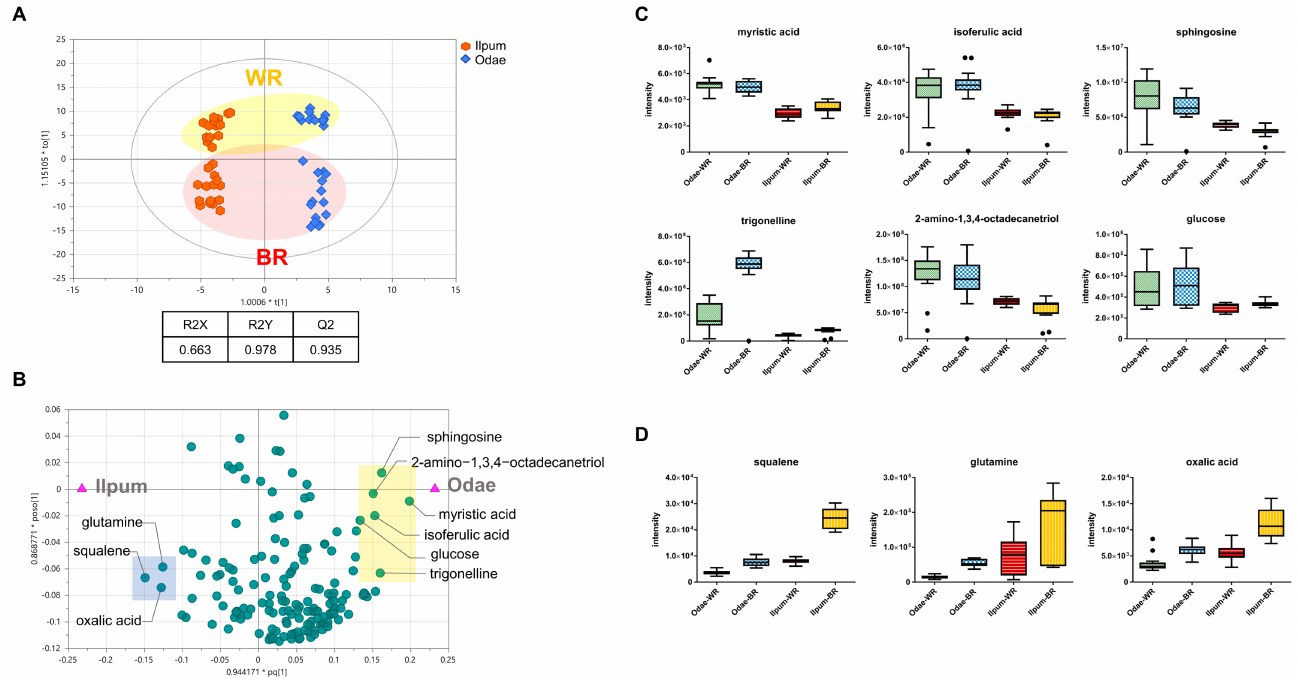
Figure 3. Cultivar-dependent metabolite profiles based on orthogonal projection to latent structures-discriminant analysis (OPLS-DA). ( A ) The score plot of the rice profiles and ( B ) loading scatter plot based on OPLS-DA. The metabolites in the yellow box present a high correlation with the Odae cultivar, whereas those in the blue box show a high correlation with the Ilpum cultivar. Box and whisker plots of the metabolites in the yellow box ( C ) and the blue box. ( D ) WR and BR indicate white rice and brown rice,